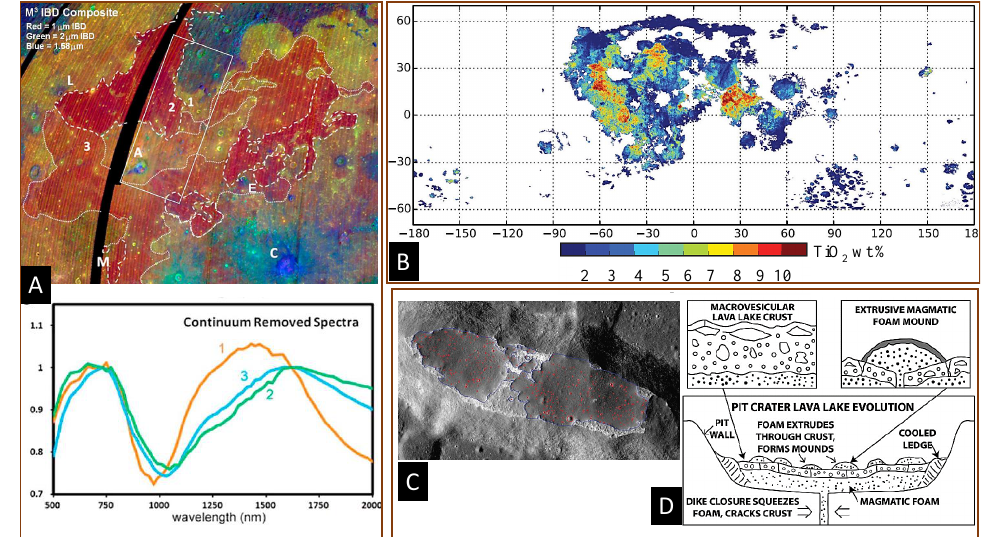
Figure 8. Insights from extrusive volcanic deposits. ( A ) Fine-scale spectral variability within western nearside basalts. The olivine abundant nature of the youngest high titanium basalts is exhibited (Source: [67]) . #1: Old and Low Titanium; #2 Youngest and High Titanium; #3 High Titanium. ( B ) Titanium abundance map of Mare basalts from modern sensors (Source: [160]) . ( C ) Irregular Mare Patches (IMPs) such as Sosigenes, exhibit very few superposed craters (marked in red circles) and have been suggested to indicate very recent volcanic episode (Source: [144]) . ( D ) Alternative model of IMPs explaining their young morphology (including absence of superposed craters) despite very old age (Source: [149])